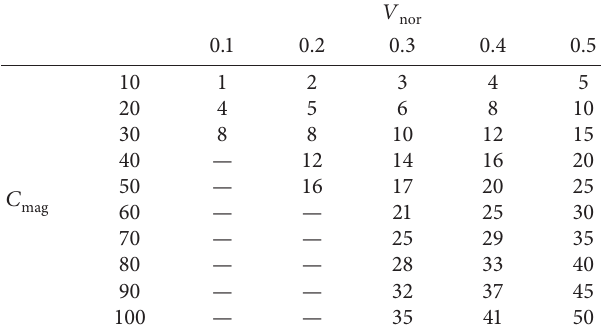
Table 5: Rebalancing order quantity per